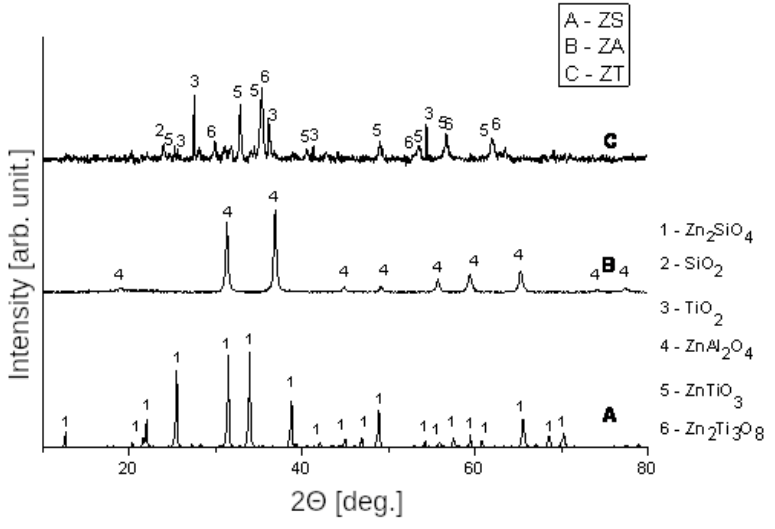
Figure 4. XRD spectra of sorbents ZT, ZS and ZA after reduction with hydrogen to a temperature of 900 ◦ C. Table 2. Results of the H 2 S sorption from model gas at 600 ◦ C.